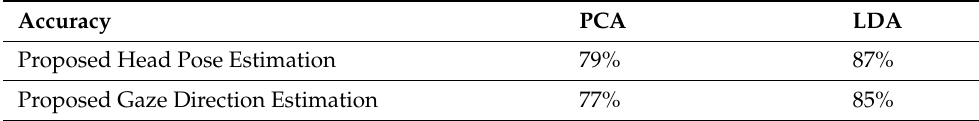
Table 6. Performance analysis of proposed system using PCA and LDA. Accuracy PCA LDA Proposed Head Pose Estimation 79% 87% Proposed Gaze Direction Estimation 77%